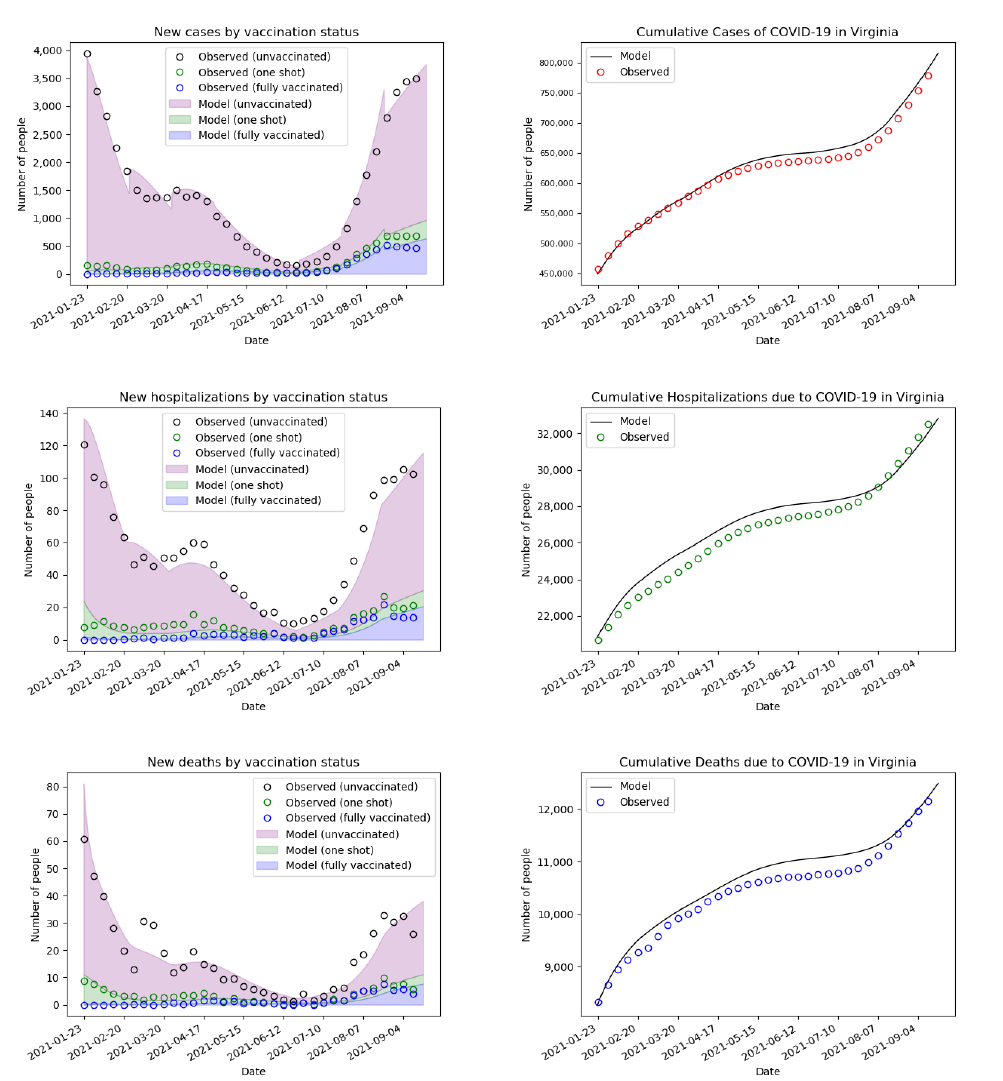
Figure 2. Plots of VDH data and the parameter-fit two-stage vaccination model (2) with piecewise- constant transmission rate β ( t ) (3) and vaccination curves V i ( t ) (4) with the parameters from Figure 1 and Table 2. On the left, we track the time-course breakdown of the new cases, hospitalizations, and deaths by vaccination status. Individual statuses are represented as bands (vertical distance between open circles for data and solid regions for model). On the right, we track the cumulative observed and model-predicted cases, hospitalizations, and deaths over